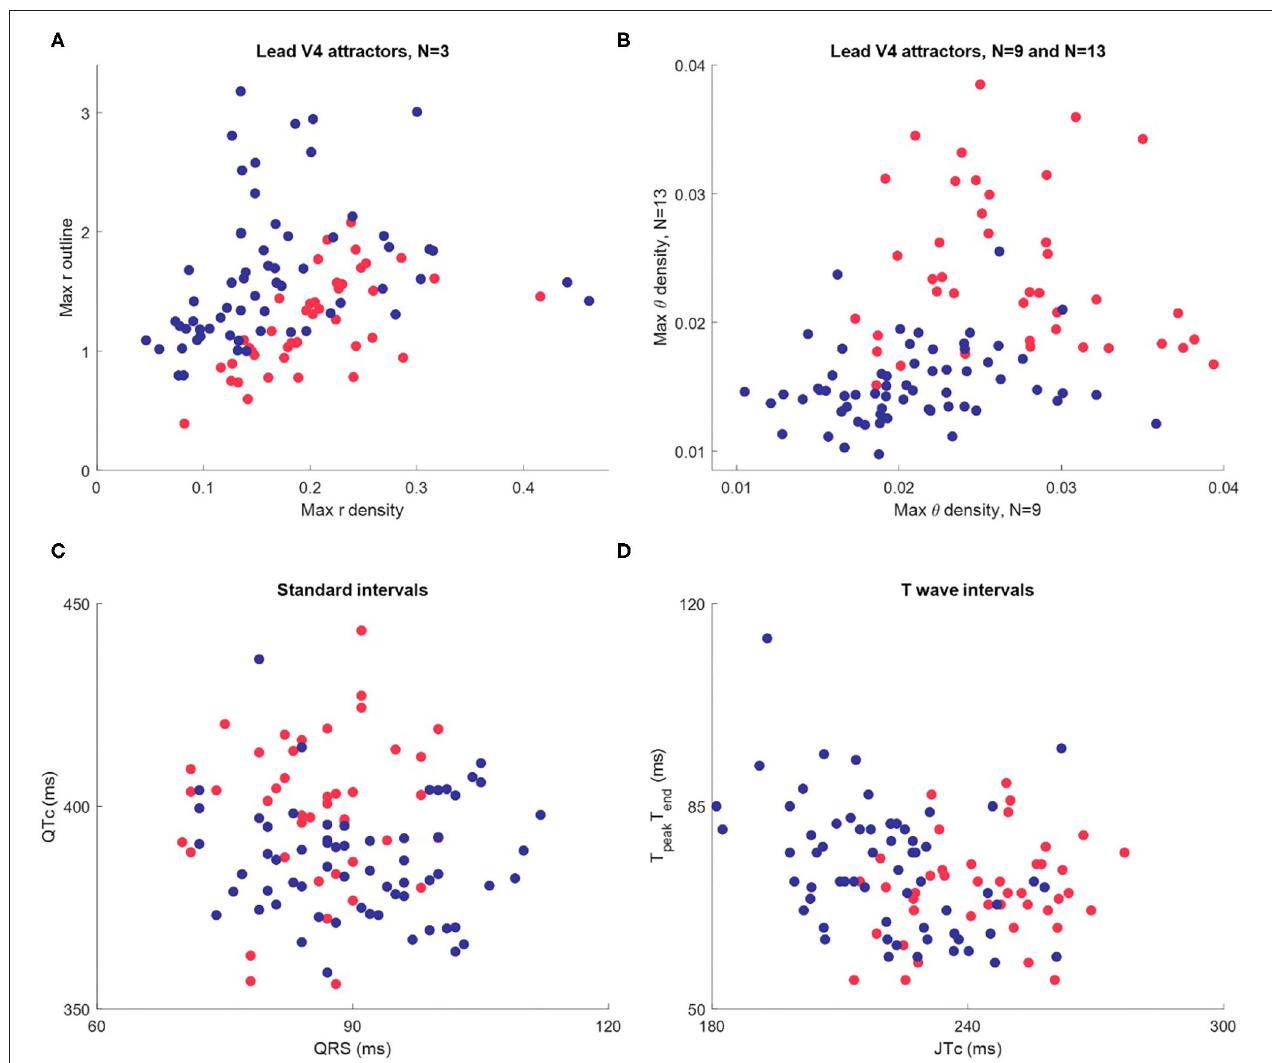
FIGURE 6 | Scatterplots of maximum attractor measures and interval measures for Dataset 1 ( n = 104, female in red, male in blue.) (A) The maximum value of each the r density and attractor outline profiles of lead V4 for 3-point attractors. (B) The maximum value of the θ density profiles of lead V4 for a 9-point and a 13-point attractor. (C) Standard intervals QTc and QRS. (D) Nuanced interval metrics JT peak c and T peak T end which segment the T wave. Whilst the interval metric scatterplots indicate differences between the sexes, the visual distinction is not as clear as in the scatterplots using SPAR